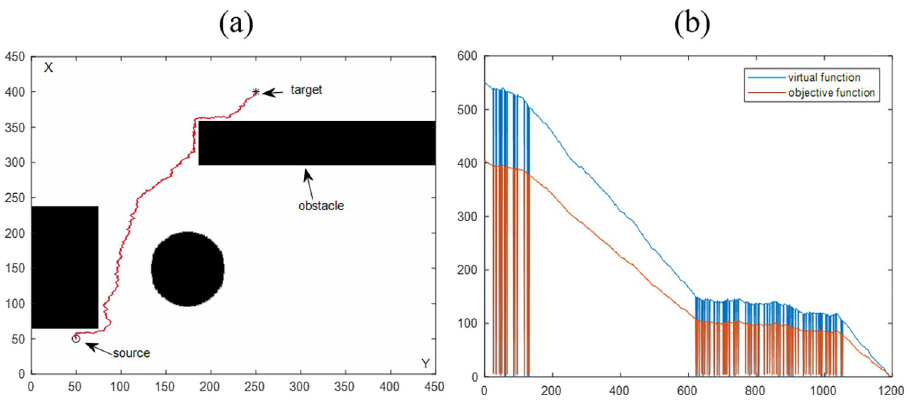
Fig 7. Path planning results are synthesized by the VBAS algorithm to avoid multiple regular obstacles. (a) Motion results in a 2D plane. (b) Relationship between function and number of iterations.